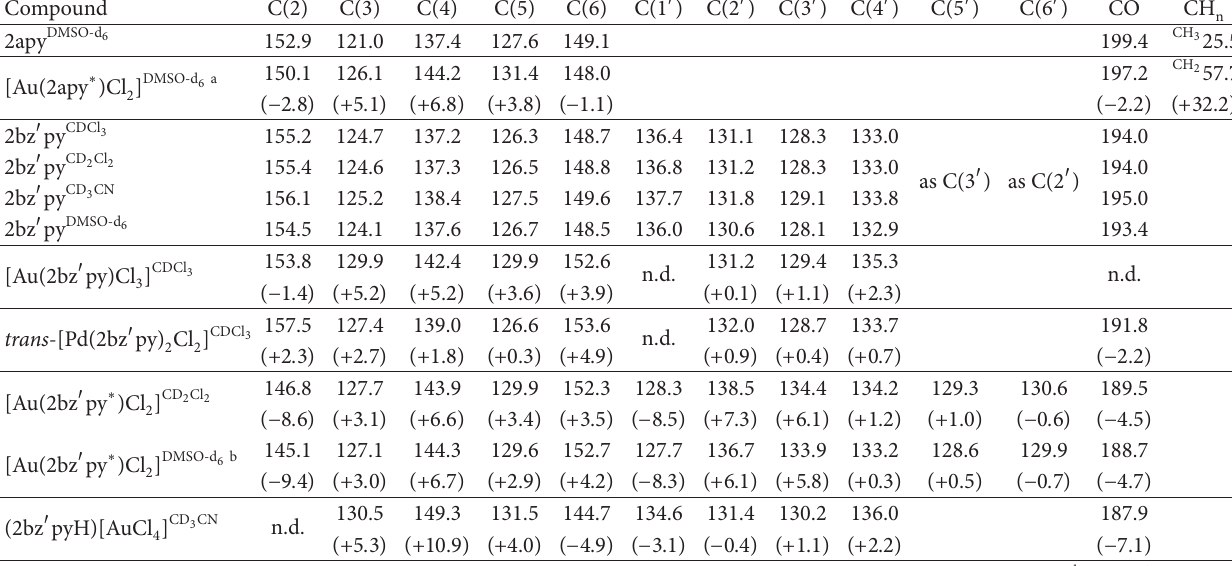
T 2: 13 C chemical and coordination/protonation shis (in parentheses) for Au(III) and Pd(II) chloride complexes, organometallics and salts with 2apy or 2bz py.